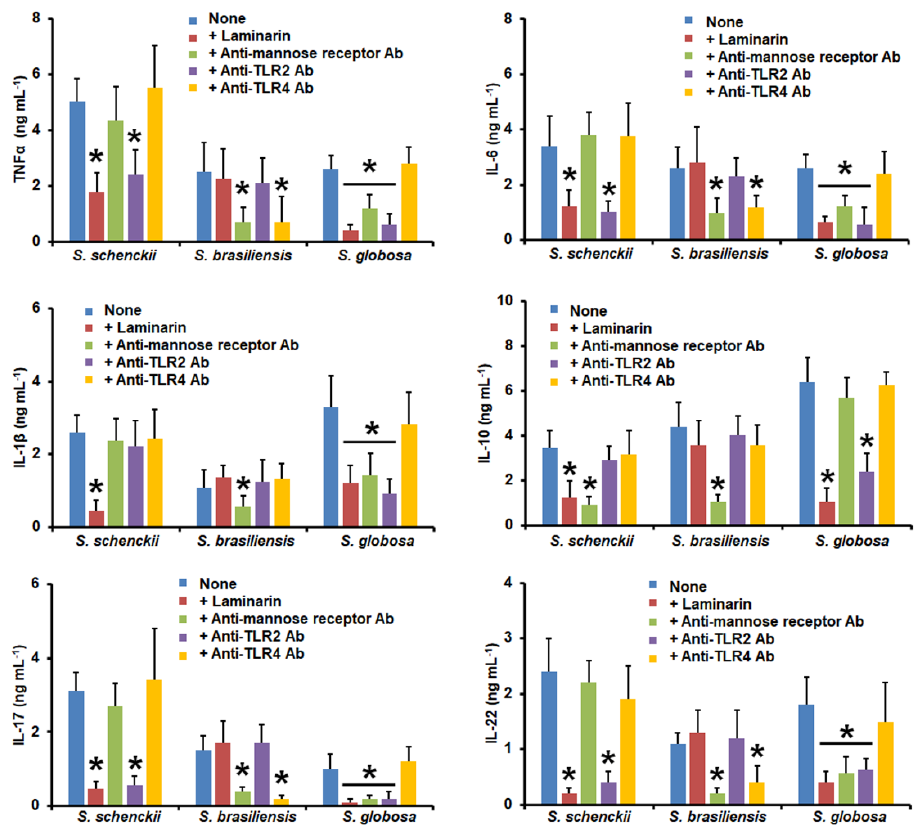
Figure 7. Cytokine production by human peripheral blood mononuclear cells pre-incubated with different blocking molecules and stimulated with yeast-like cells from Sporothrix schenckii , Sporothrix brasiliensis , or Sporothrix globosa . Human peripheral blood mononuclear cells were pre-incubated for 60 min with 200 µg mL − 1 of laminarin, 10 µg mL − 1 of anti-mannose receptor, 10 µg mL − 1 of anti-TLR2, or 10 µg mL − 1 if anti-TLR2, and then challenged with yeast-like cells. For tumor necrosis factor-alpha (TNF α ), interleukin 1 β (IL-1 β ), interleukin 6 (IL-6), and interleukin 10 (IL-10), human peripheral blood mononuclear cells were co-incubated for 24 h with live yeast-like cells, whilst for interleukin 17 (IL-17) and interleukin 22 (IL-22) stimulation, the human cells were co-incubated with the UV- killed fungal cells. In all cases, the interactions were centrifuged, supernatants collected, and cytokines quanti fi ed by ELISA. Ab—antibody; S. — Sporothrix . None refers to the system where the human cells were pre-incubated only with PBS. Results are the median ± standard deviation from data generated with samples from eight donors, analyzed in duplicate. * p < 0.05 when compared with the cytokine level stimulated by PBS-pre-incubated cells.